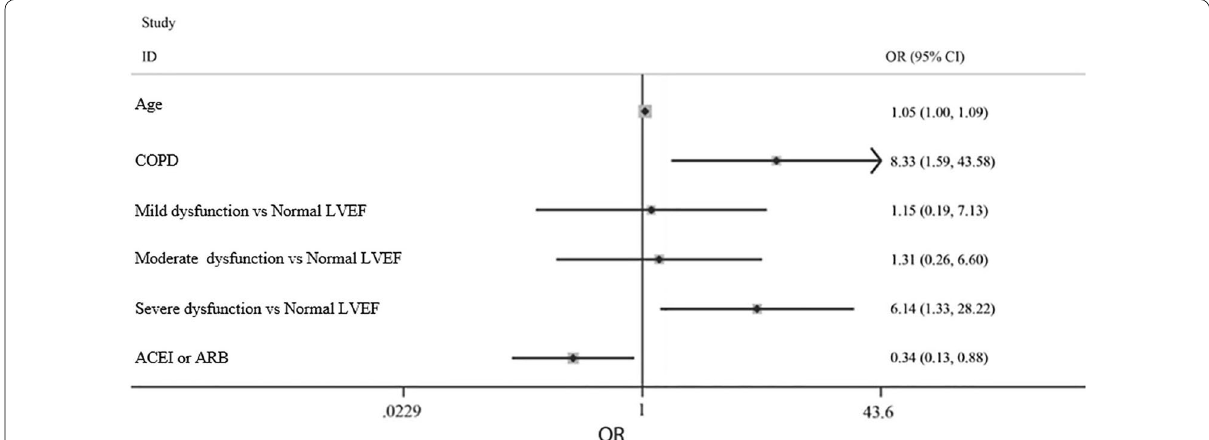
Fig. 1 Forest plot scheme in the multivariable model. P value for the Hosmer–Lemeshow test: 0.612. ACEI Angiotensin‑converting‑enzyme inhibitor, ARB Angiotensin II receptor blocker, COPD Chronic obstructive pulmonary disease, LVEF Left ventricular ejection